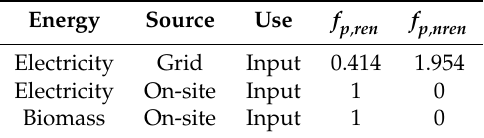
Table 3. Primary Energy factors defined in the Spanish Building Standards.